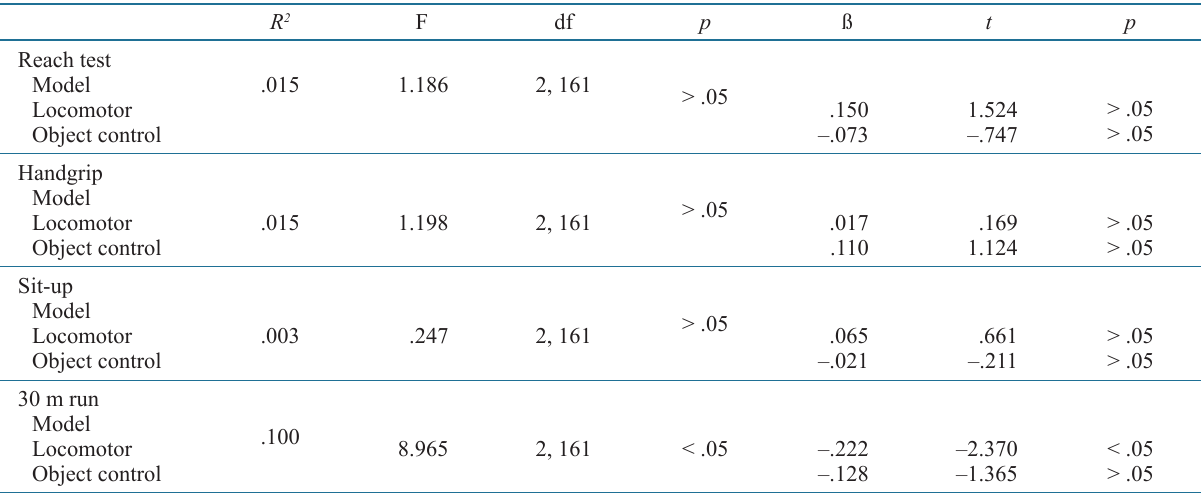
Linear regression model examining the influence of level of fundamental motor skills on physical test outcome